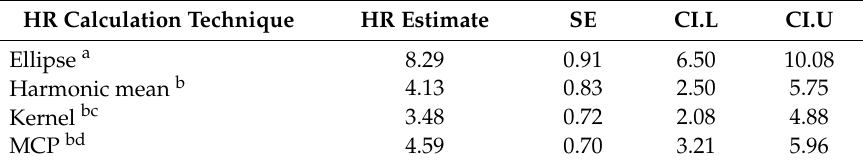
Table 4. Raw mean home range estimates with standard error (SE) and 95% confidence intervals (CI.L and CI.U) for all Terrapene studies by HR technique. Superscript letters show di ff erences among estimators, based on Holm–Bonferroni pairwise post hoc comparisons. MCP: minimum convex polygons.